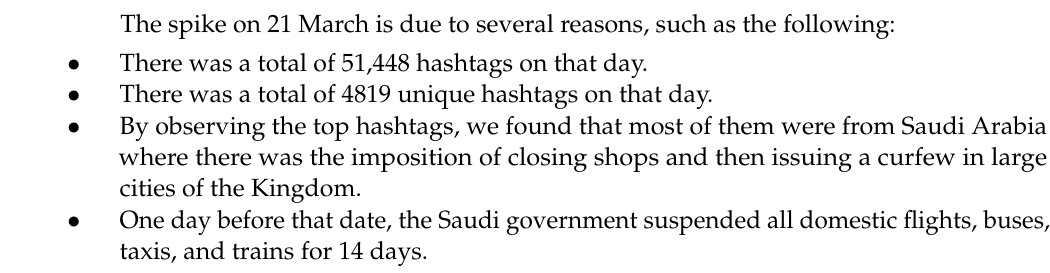
Figure 3. Tweets Distribution